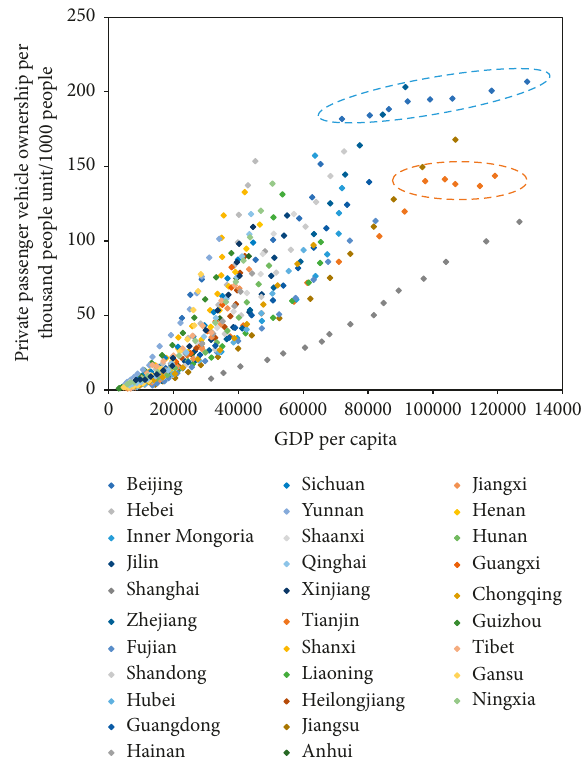
Figure 2: Private passenger vehicle ownership per thousand people based on GDP per capita from 2002 to